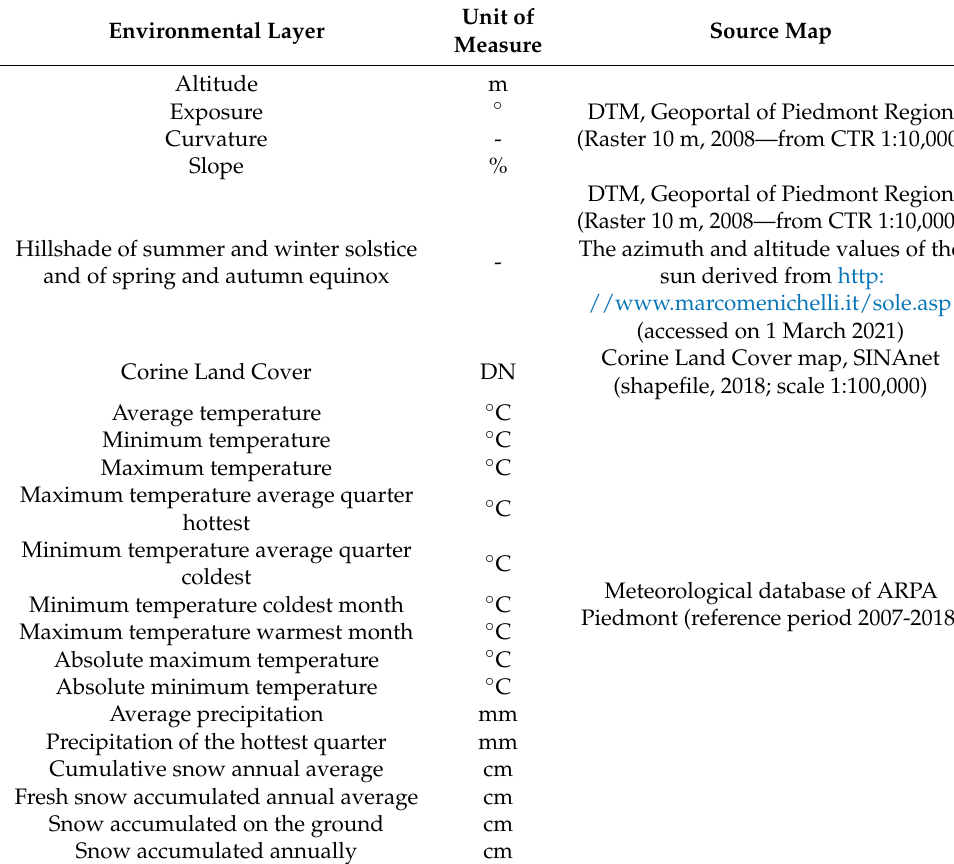
Table 2. List of environmental variables considered for the implementation of the MaxEnt model. For each variable, the unit of measure, the source data and scale. Unit of Source Map Environmental Layer Measure Altitude m 1:10,000)Exposure ◦ DTM, Geoportal of Piedmont Region Curvature - (Raster 10 m, 2008—from CTR Slope % DTM, Geoportal of Piedmont Region (Raster 10 m, 2008—from CTR 1:10,000). Hillshade of summer and winter solstice The azimuth and altitude values of the - and of spring and autumn equinox sun derived from http: